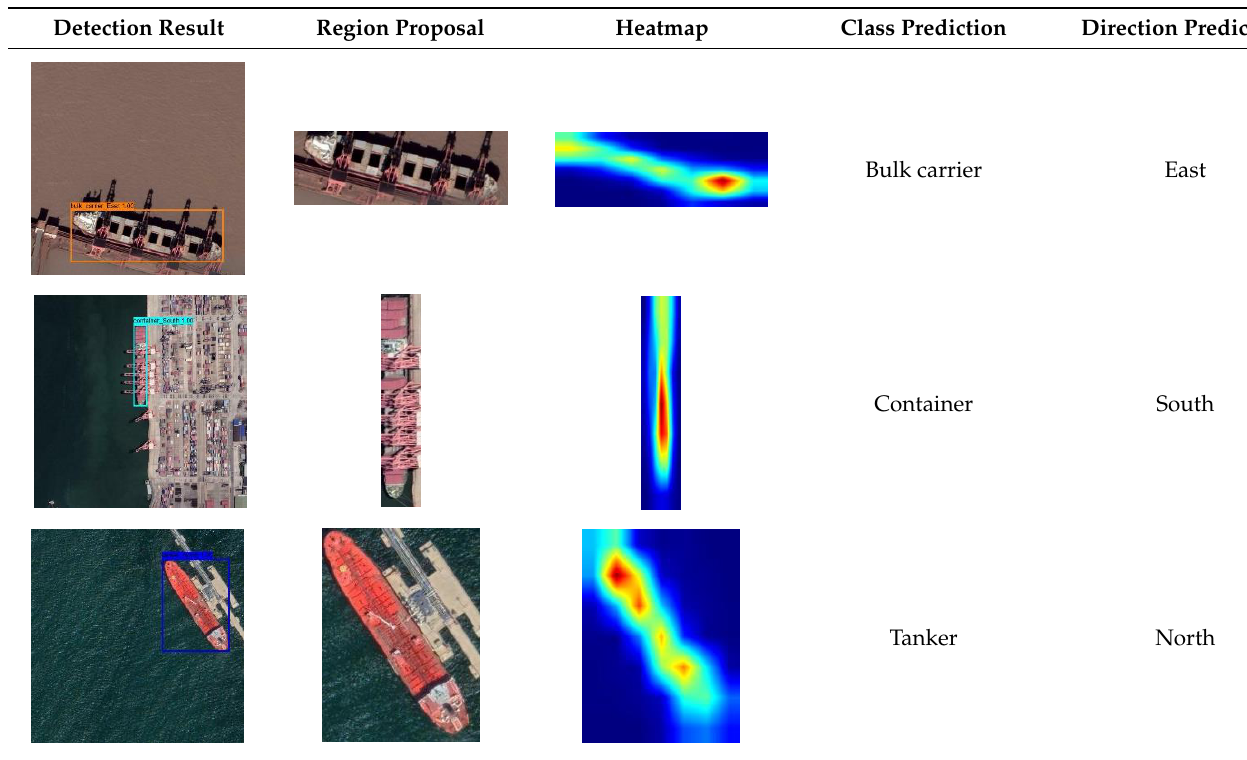
Table 6. Detection results and corresponding heatmaps.